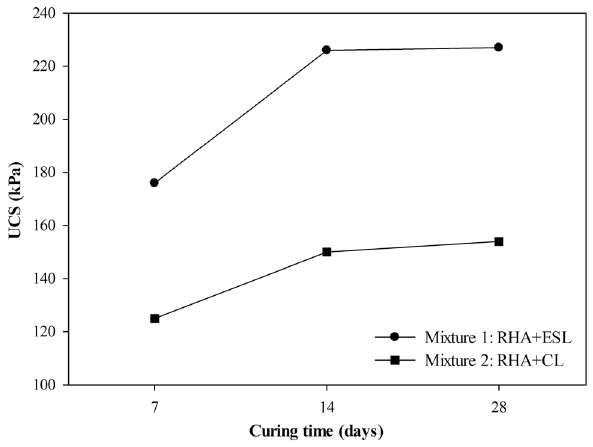
Figure 8. Unconfined compression strength at 7, 14, and 28 days of curing the mixtures.